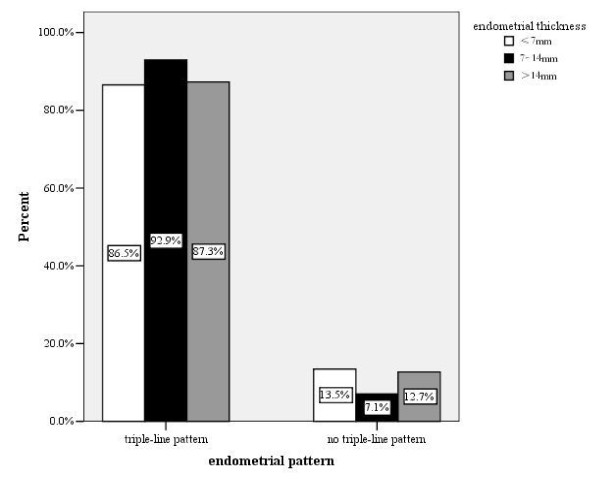
Distribution of endometrial patterns in three endometrial thickness groups. The percentages of endometrial pattern are shown for individual endometrial thickness group.